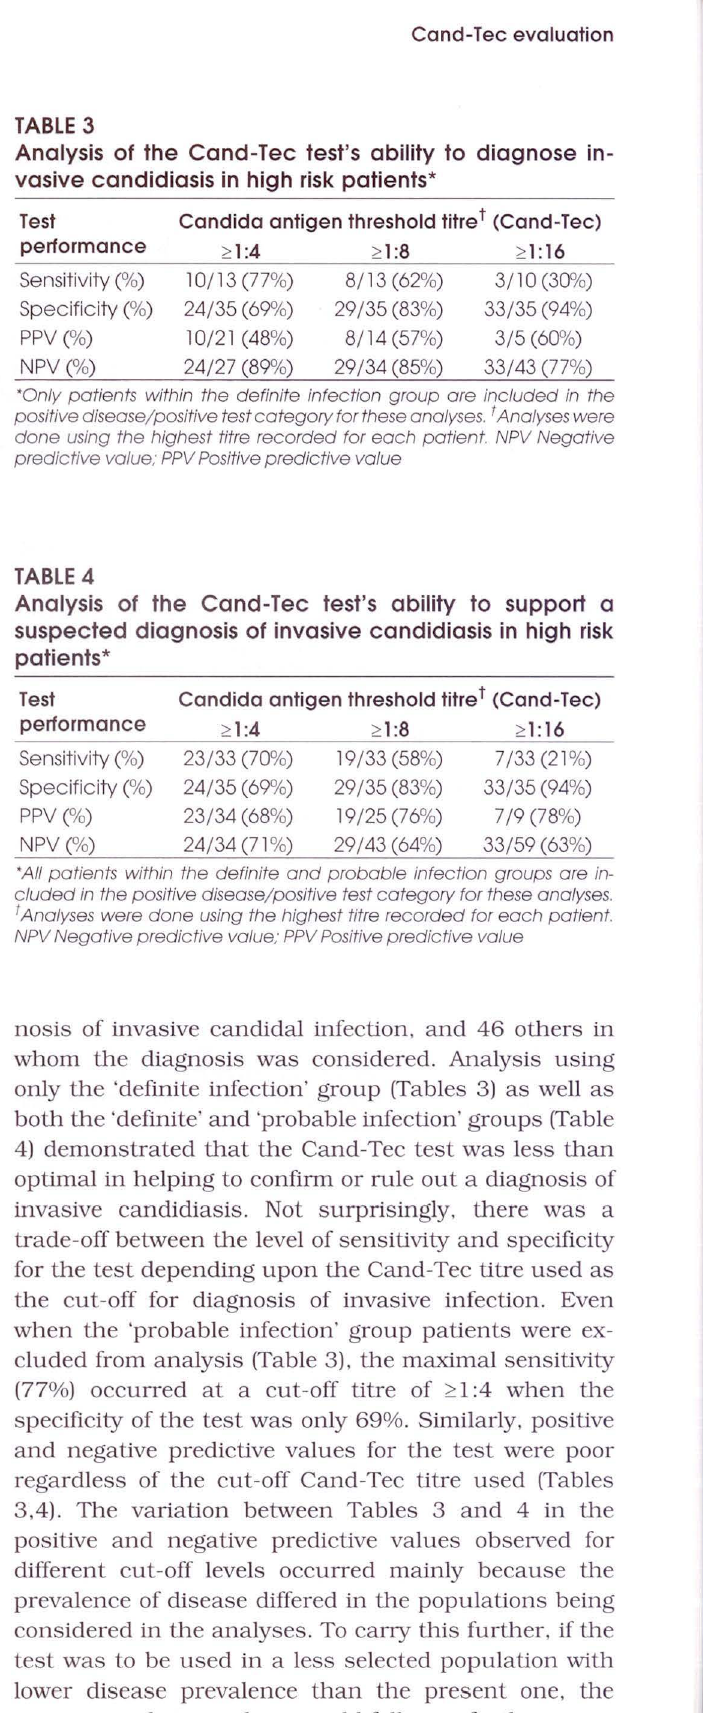
Analysis of the Cand-Tec test's ability to diagnose in vasive candidiasis in high risk patients* Test Candida antigen threshold titret (Cand-Tec)